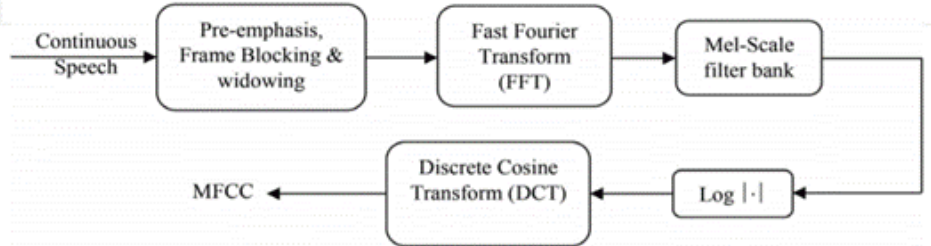
Figure 8. Five steps to extracting MFCC features [33]. It shows the steps followed to extract MFCC features that are used for the training and testing of the machine learning